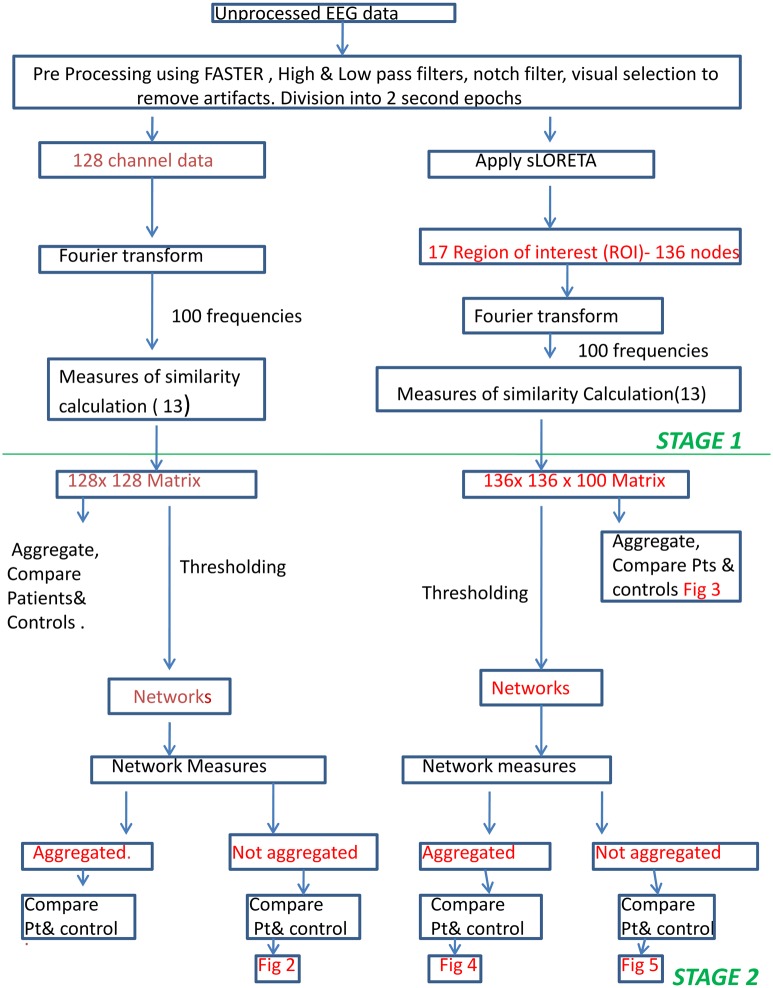
Methods Flow Chart.Flowchart of methods explaining the preprocessing and two stage processing for scalp connectivity and nodal connectivity.